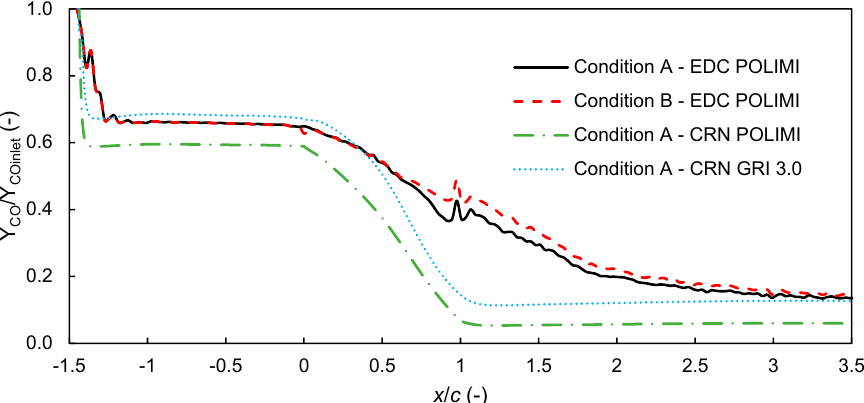
Figure 14. CO mass fractions for take-off conditions (A and B) calculated utilising the CFD model with the EDC, and the CRN